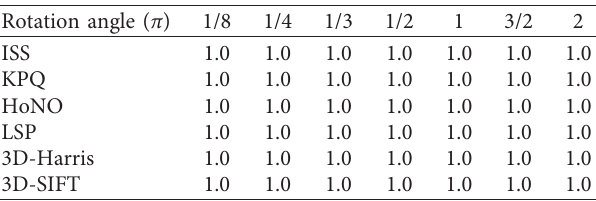
Table 1: The average value of the spatial repetition rate r key point detection algorithm on the 4 data sets.